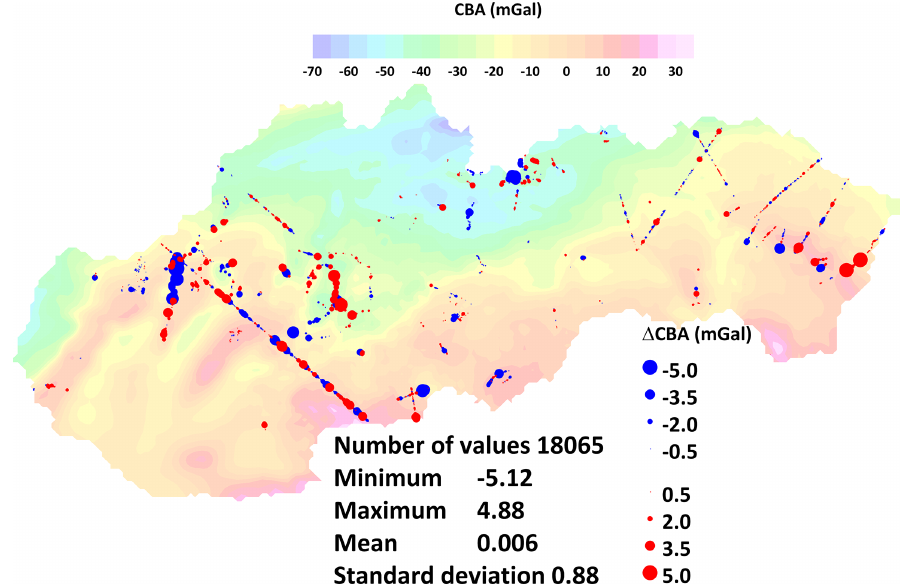
Figure 14. Differences between the CBA grid and independent gravity points (not used for the Slovakian part of the gravity grid compilation). It was calculated by SURFER’s simple grid-residual procedure and showed that no gravity differences were greater than ± 5mGal.